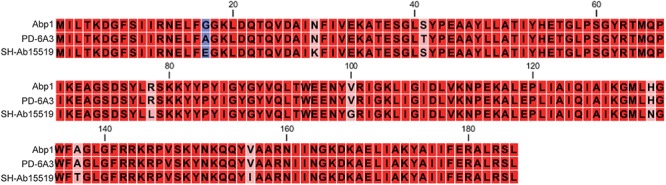
Amino acid sequence alignment of the endolysin of Phage PD6A3. The sequences used for alignment analysis were the endolysin gene of Phage 6A3, Phage SH-Ab15519 and Phage Abp1. Eight mutation residues are indicated by different color.